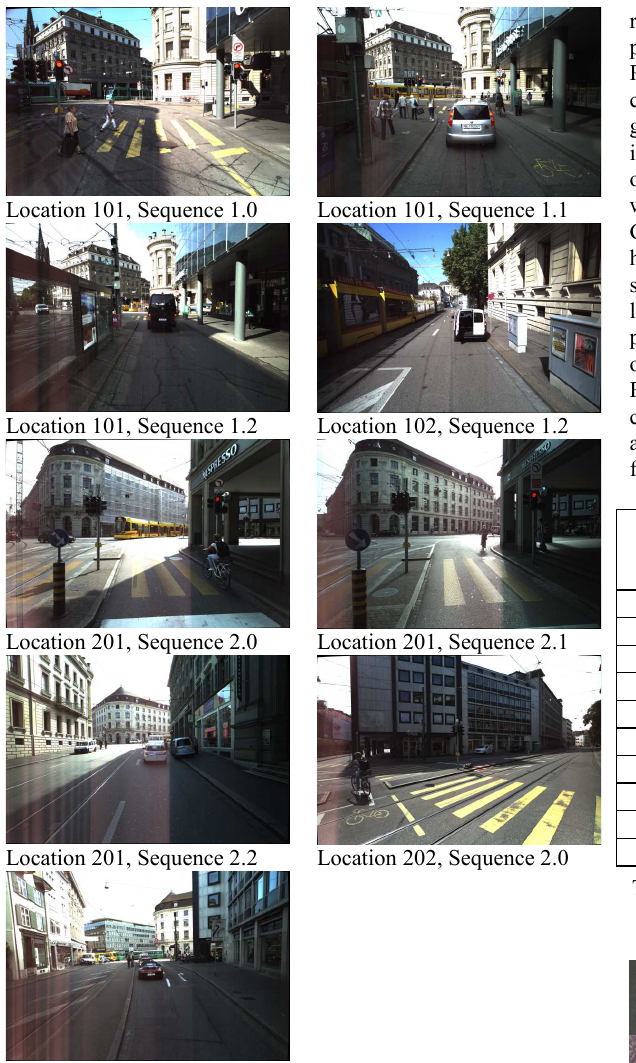
Figure 15. Mobile mapping imagery captured at locations of